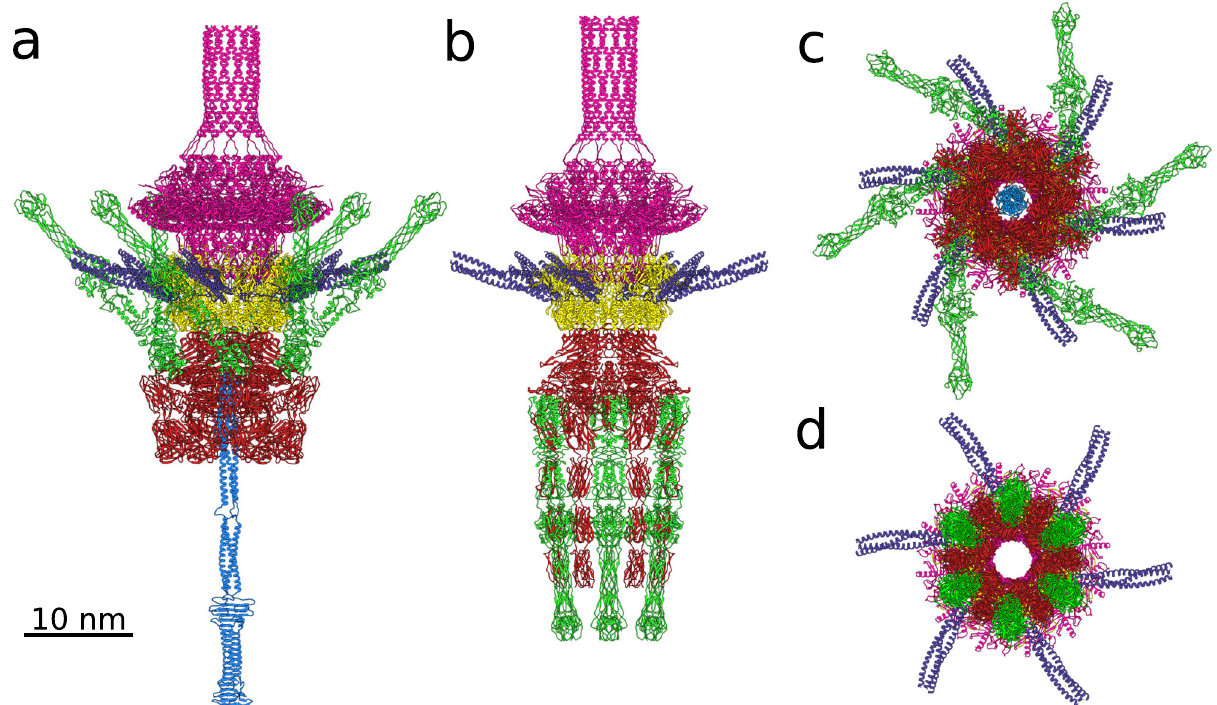
Fig. 2 | Conformational changes of SU10 tail associated with genome release. Cartoon representations of proteins forming tail of SU10 virion a , c and genome release intermediate b , d . The portal protein (gp6) is shown in magenta, adaptor protein(gp11)inyellow,longtail fi berprotein(gp12)inviolet,nozzleprotein(gp17) inred,shorttail fi berprotein(gp16)ingreen,andtailneedleprotein(gp18)inlight blue. a , b views perpendicular to the tail axis and c , d views along the tail axis towards the phage head. In the SU10 virion, the short tail fi bers are tilted